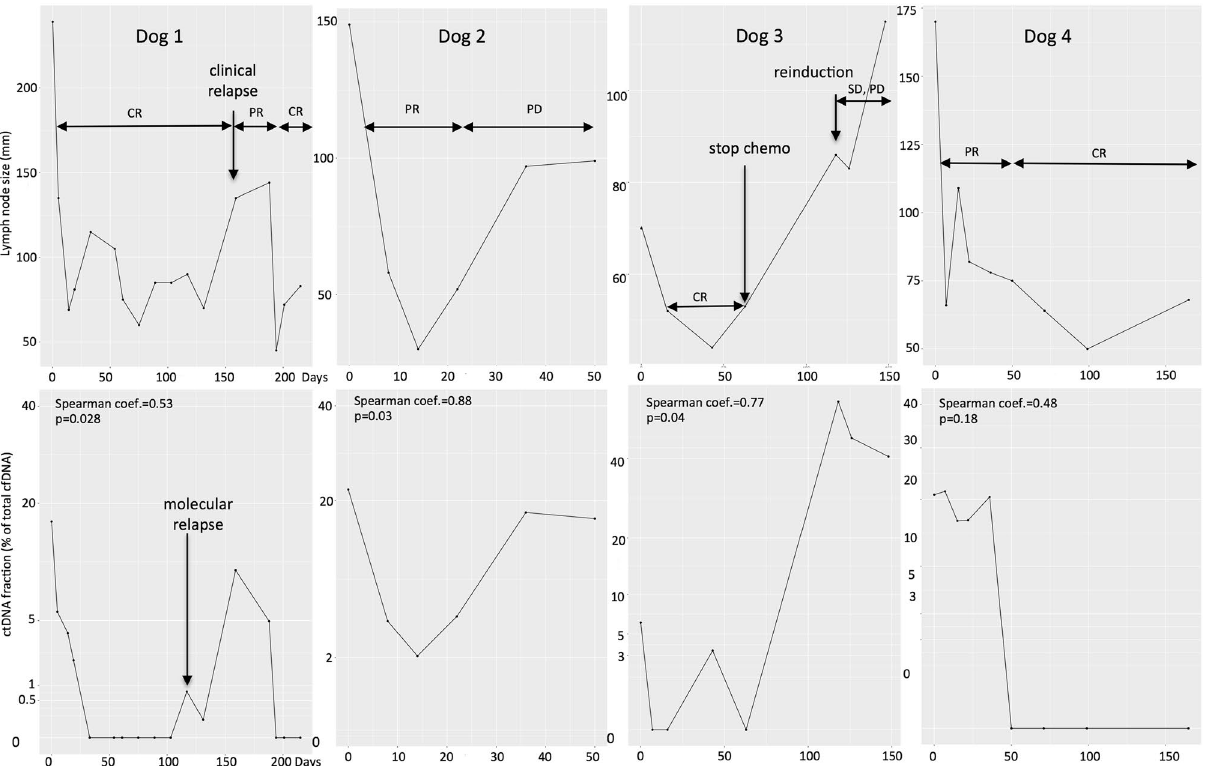
Figure 4. Course of disease for four dogs with lymphoma that were treated using chemotherapy (dog 1: 18182, dog 2: 18710, dog 3: 18680, dog 4: 18744) (drawing produced by R studio software Version 1.1.463; Vienna, Austria 60 ). For each dog, the figures above represent the tumor burden with lymph node size (sum of longest diameter of at least 2 lymph nodes; in mm). The figures below represent the ctDNA measurement (% of total cfDNA in plasma) during the disease. For each case, a Spearman correlation analysis was performed to assess the correlation between the tumor burden and ctDNA quantity (coefficient and p value). CR complete response, PR partial response, SD stable disease, PD progressive